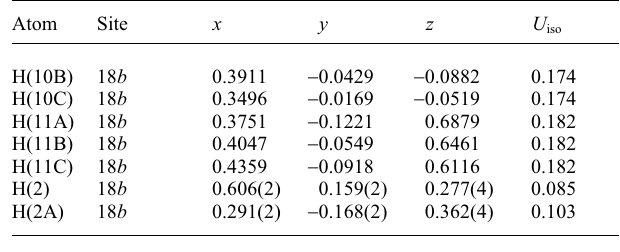
Table 3. Atomic coordinates and displacement parameters (in Å 2 ) .